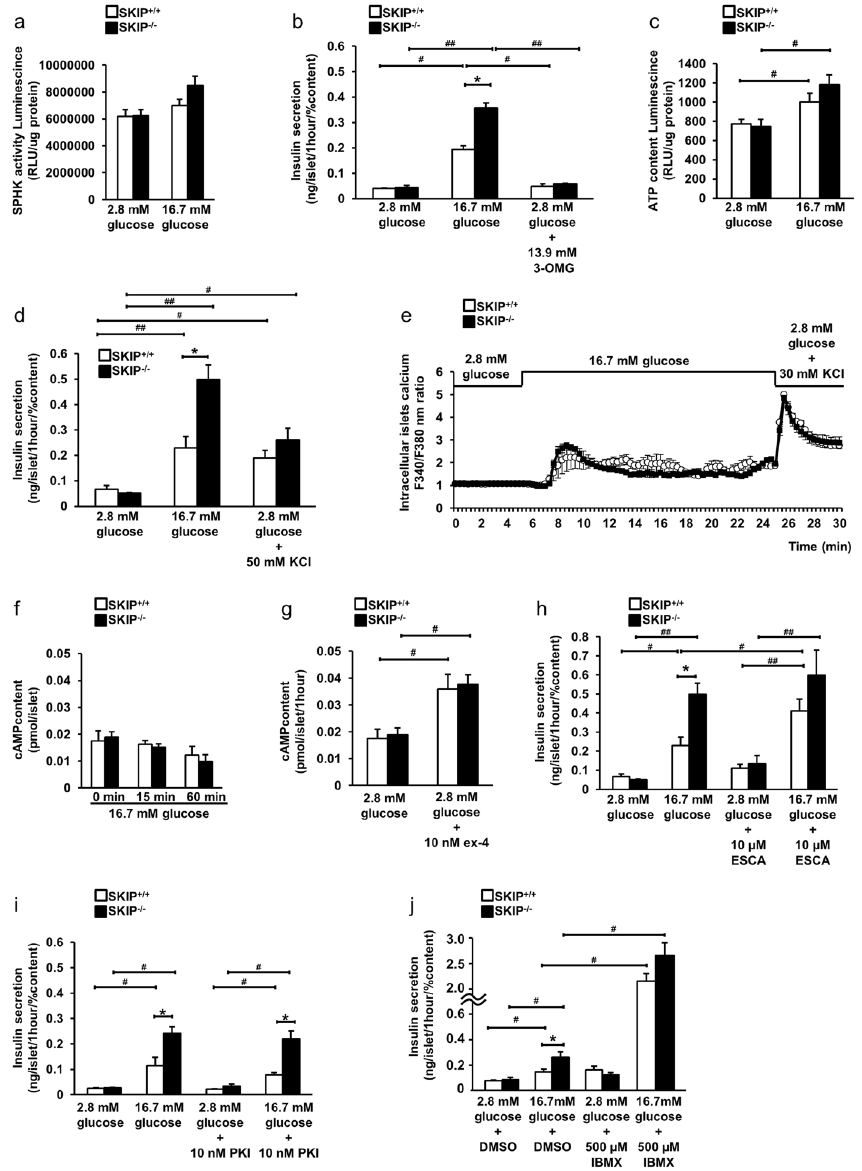
Figure 6. The mechanism of SKIP-involved insulin secretion. ( a ) Sphingosine kinase activity from isolated islets measured at 2.8 mM and 16.7 mM glucose. ( b ) Insulin secretion measured at 2.8 mM, 16.7 mM glucose and 2.8 mM with 13.9 mM non-metabolic glucose (3-OMG). ( c ) ATP content from isolated islets measured at 2.8 mM and 16.7 mM glucose. ( d ) Potassium-evoked insulin secretion in isolated islets from SKIP − / − mice. Insulin secretion measured at 2.8 mM, 16.7 mM glucose and 2.8 mM with 50 mM KCl. ( e ) Calcium influx measured in islets from SKIP + / + and SKIP − / − mice. ( f ) cAMP content in isolated islets from SKIP + / + and SKIP − / − mice stimulated at 16.7 mM glucose for 0 min, 15 min, 60 min. ( g ) cAMP content in isolated islets from SKIP + / + and SKIP − / − mice at 2.8 mM glucose with or without 10 nM ex-4. ( h ) Epac2 selective activator (ESCA)-stimulated insulin secretion in islets from SKIP + / + and SKIP − / − mice. Insulin secretion measured at 2.8 mM or 16.7 mM glucose with or without 10 μ M ESCA in the isolated islets. ( i ) PKA-dependent insulin secretion in islets from SKIP + / + and SKIP − / − mice. Insulin secretion from isolated islets measured at 2.8 mM or 16.7 mM glucose with or without 10 nM PKI. ( j ) GSIS treated with 3-isobutyl-1-metylxantine (IBMX) in islets from SKIP + / + and SKIP − / − mice. Insulin secretion was measured at 2.8 mM or 16.7 mM glucose with or without 500 μ M IBMX in the isolated islets. ( a – j ) 12-week-old mice were used for the experiments. * p < 0.05, ** p < 0.005 vs SKIP + / + , # p < 0.05, ## p < 0.005 for different stimulated conditions in the same genotype mice of insulin secretion. ( a – d , h – j ) n = 7–8 mice per group and 5–6 samples per group, 10 islets per sample. ( e ) n = 3 mice per group and 3 samples per group, 12–20 islets per sample. ( f , g ) n = 6–7 mice per group and 5–6 samples, 25 islets per group. Data are expressed as average ± SEM. Significance was determined by one way ANOVA with Tukey test ( a – d , f – j ) and student’s t-test ( e